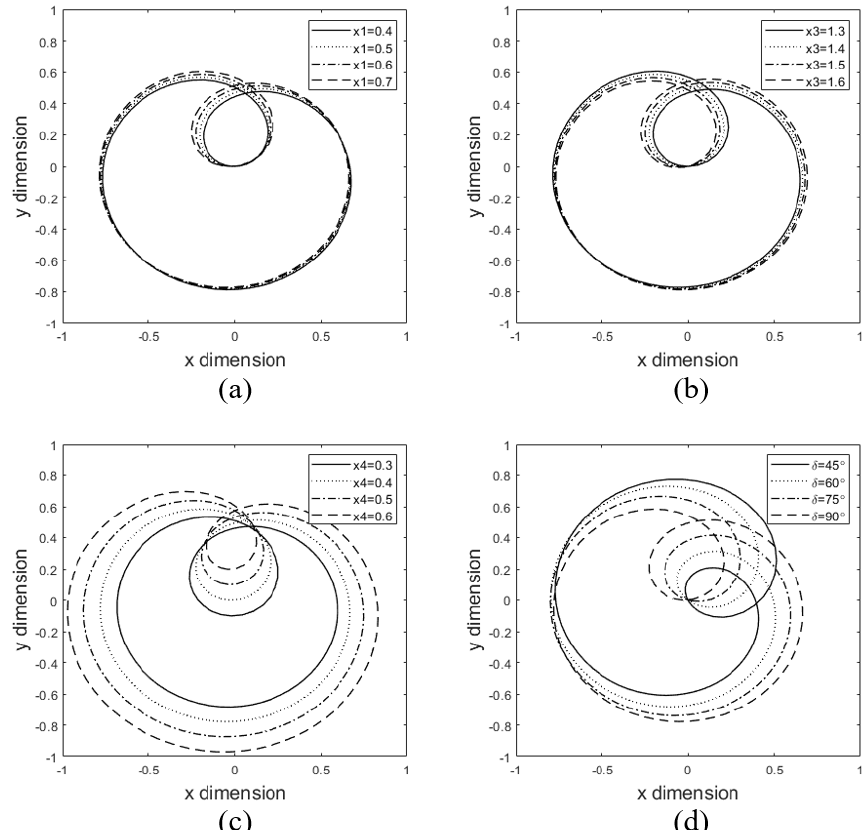
Figure 12. The effect of parameters on trajectory of the guidance point. (a) x 1 . (b) x 3 . (c) x 4 . (d) δ